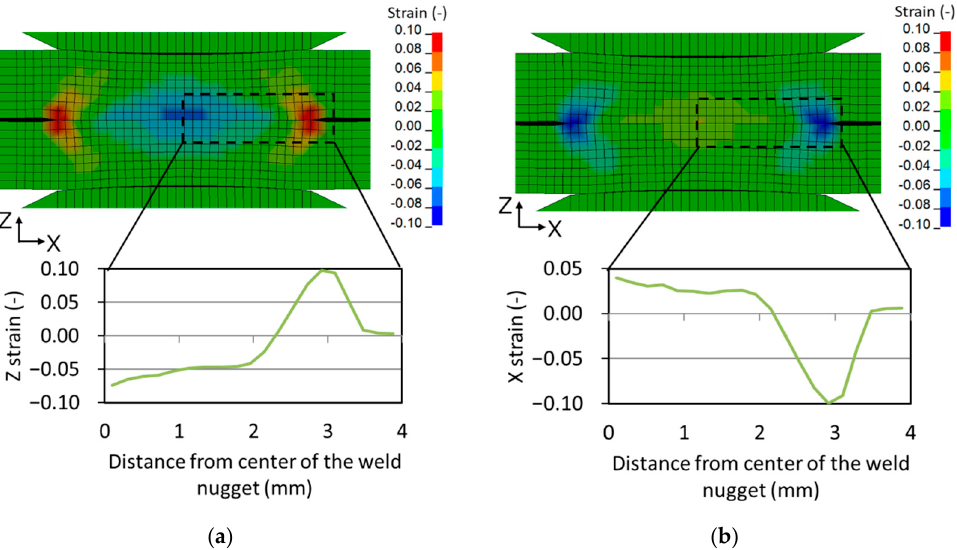
Figure 3. FE model for the process simulation.